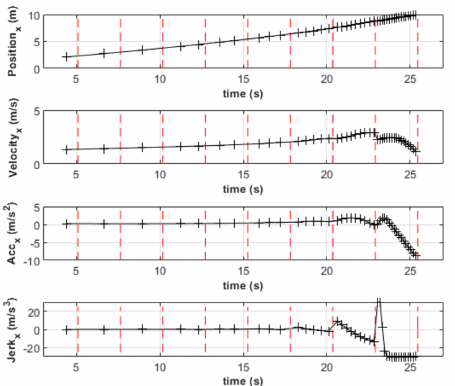
Figure 11. Planned trajectory of updates during the landing in simulation